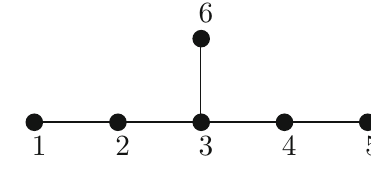
Fig. 1 The Dynkin diagram for the Lie algebra E